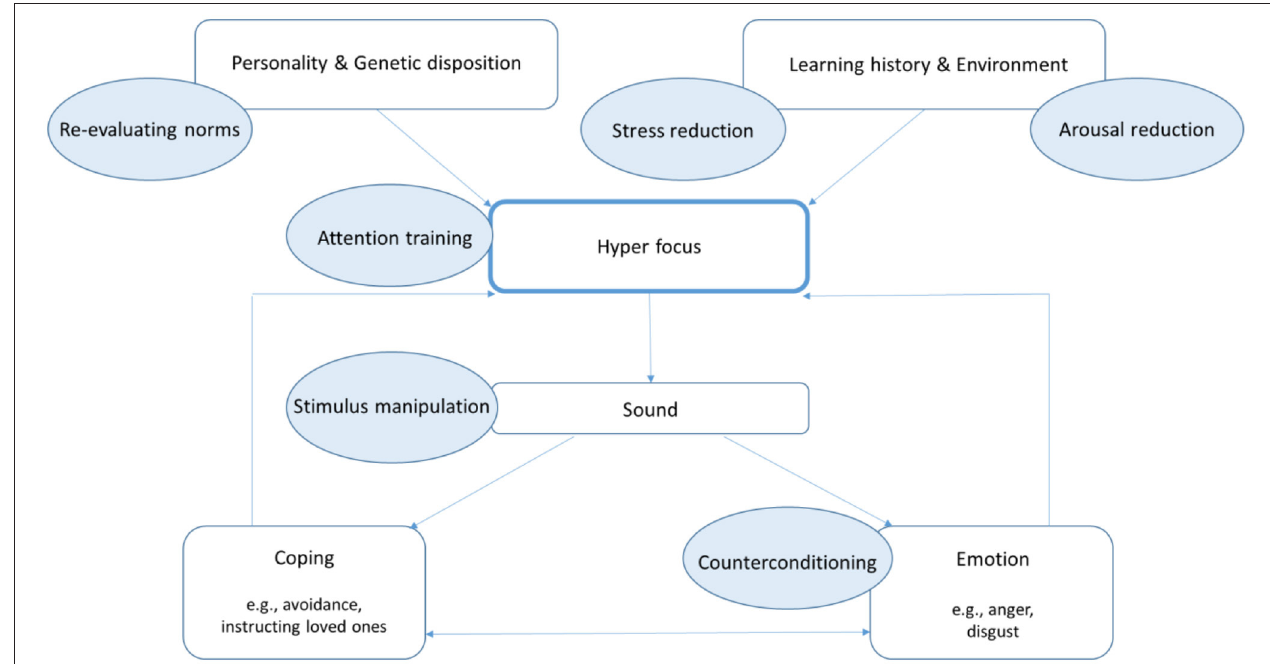
FIGURE 3 | Biopsychosocial model of